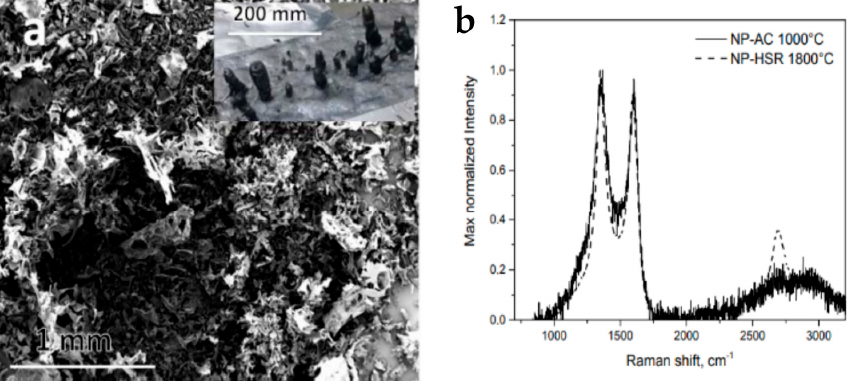
Figure 3. Nanostructured carbon material produced from Pitch pyrolysis at 1800 ◦ C. ( a ): SEM images and, in the indent, morphology of produced char; ( b ) Raman spectra (from